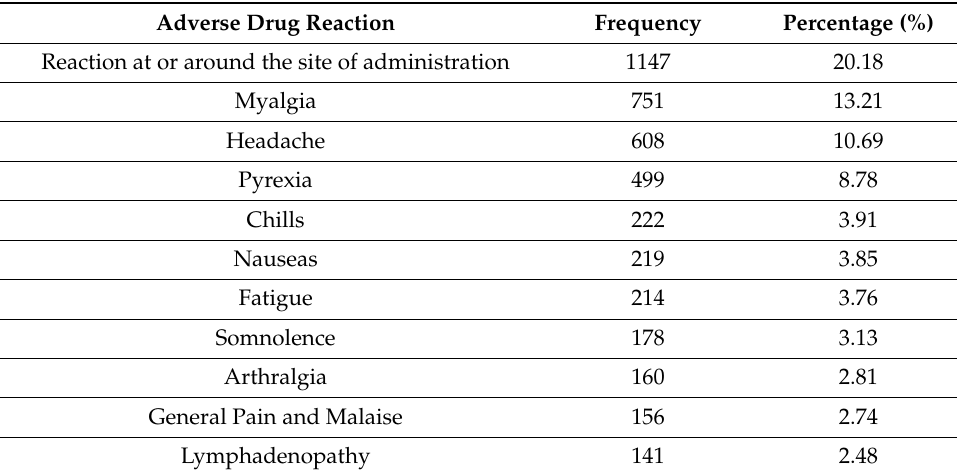
Table 3. Characterization of Adverse Drug Reactions according to the Preferred